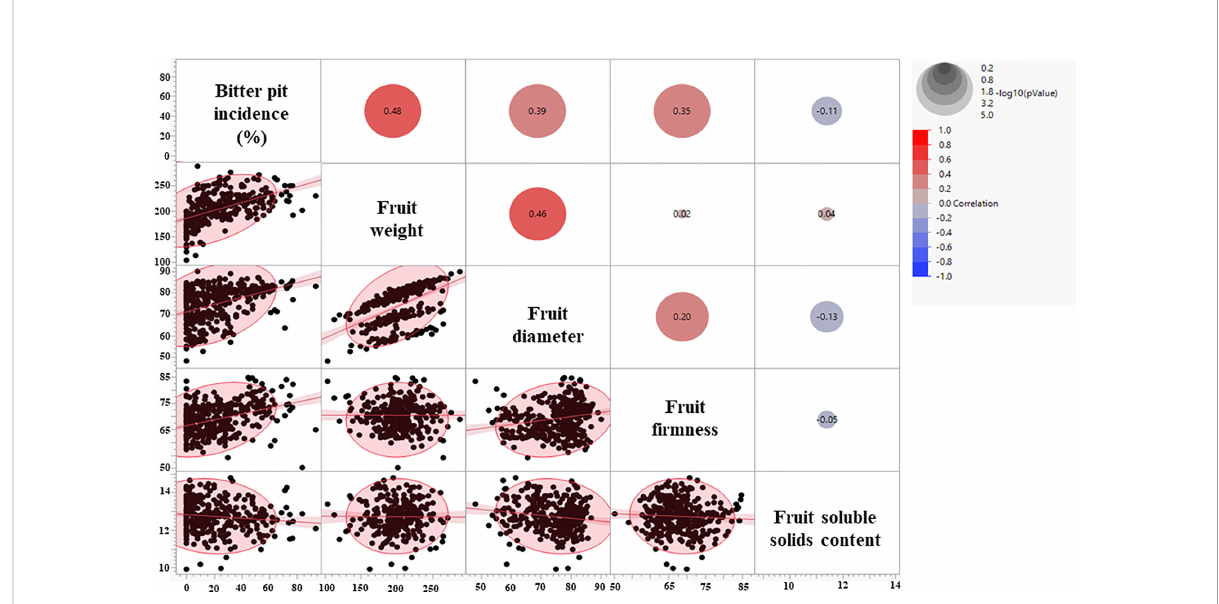
FIGURE 2 Correlation coef fi cients between bitter pit incidence and fruit quality parameters at harvest.